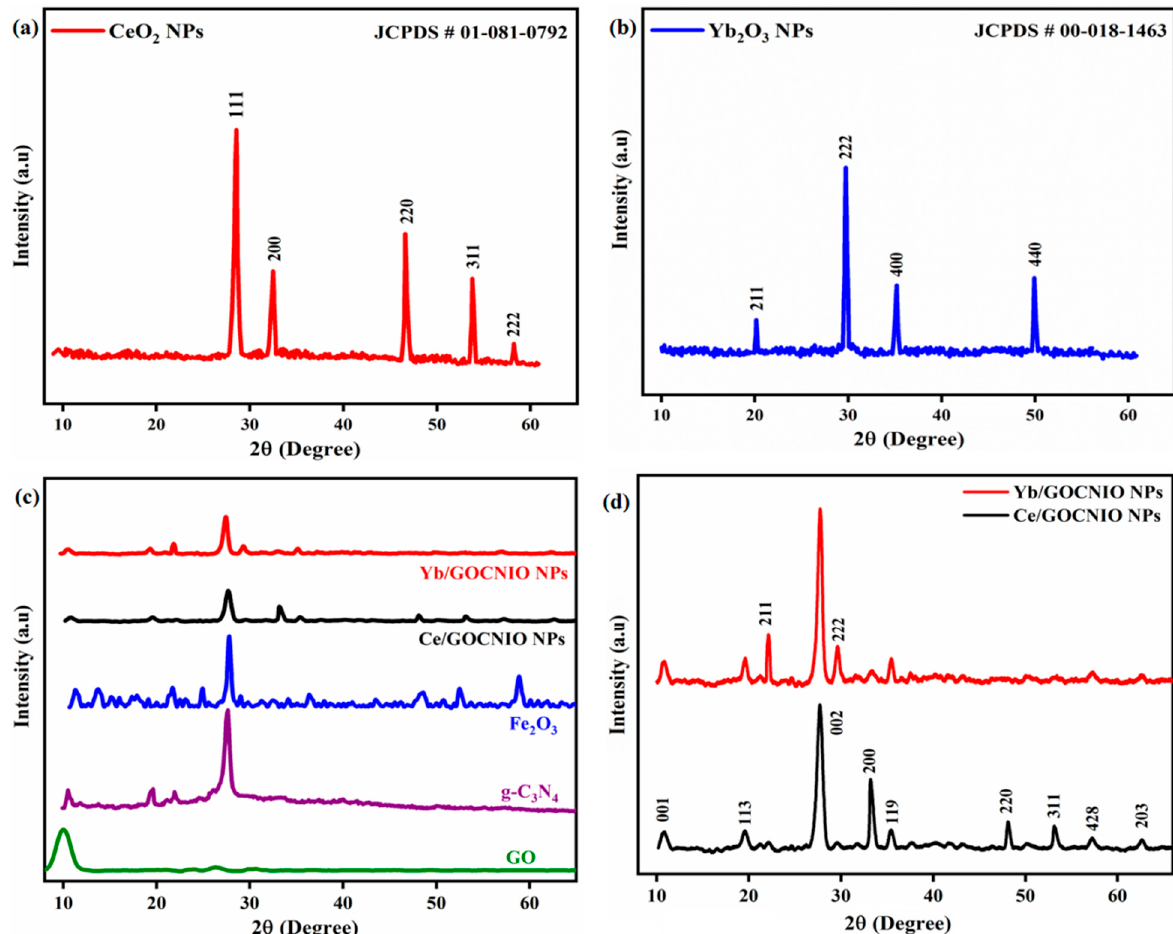
Figure 2. XRD patterns of ( a ) CeO 2 NPs; ( b ) Yb 2 O 3 NPs; ( c ) GO, g-C 3 N 4 , Fe 2 O 3 , Ce/GOCNIO NPs, and Yb/GOCNIO NPs; ( d ) Ce/GOCNIO NPs; and Yb/GOCNIO NPs.